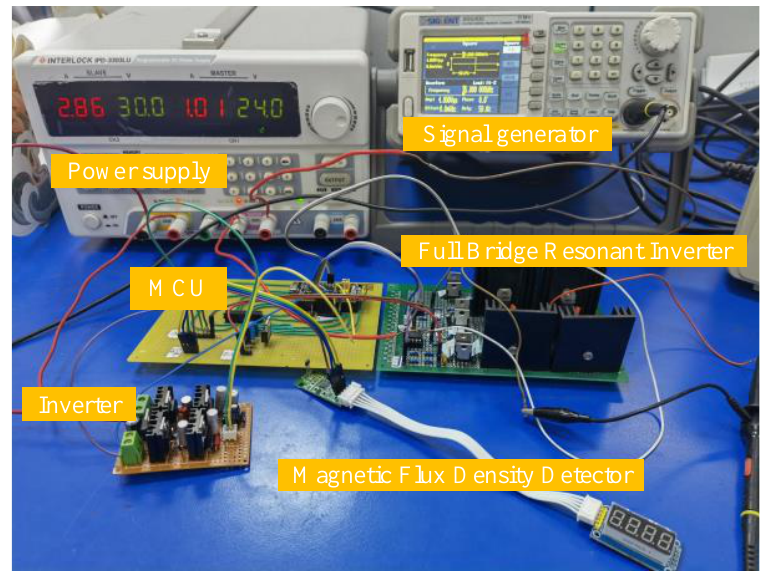
Figure 13. Experimental setup.